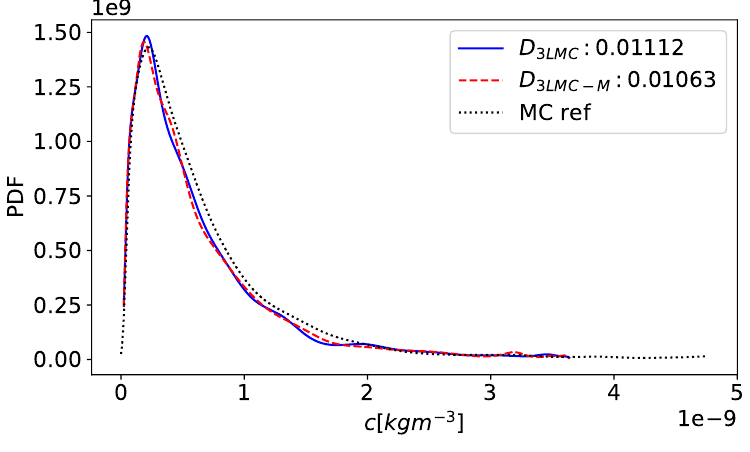
Figure 7. PDFs approximated by moments estimated via 3LMC (blue) and 3LMC-M (red dashed). Both compared to the reference MC (black dotted) by the Kullback–Leibler divergence D